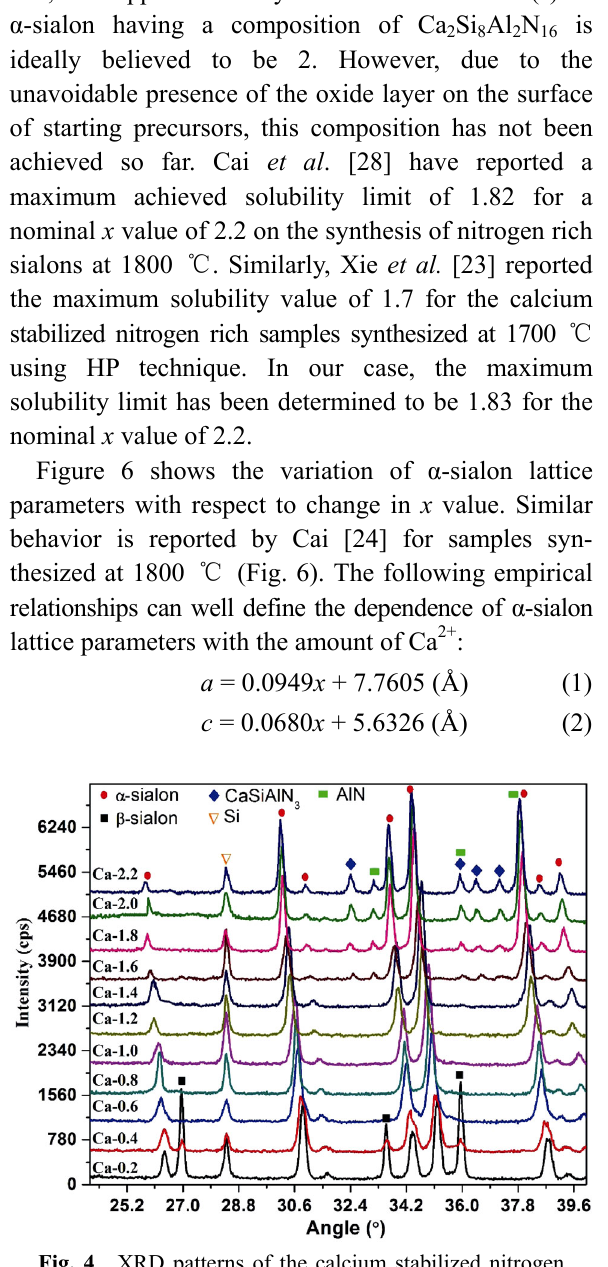
Fig. 4 XRD patterns of the calcium stabilized nitrogen rich α-sialon samples synthesized along the Si 3 N 4 :1/2Ca 3 N 2 : 3AlN line at synthesis temperature of 1500 ℃